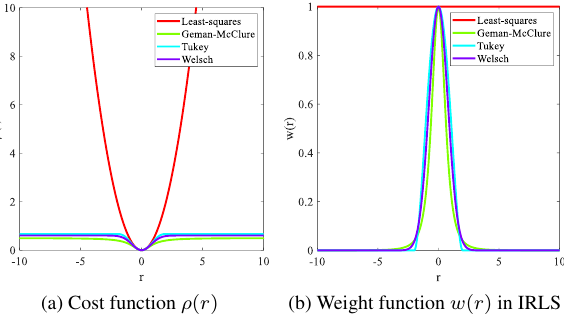
Figure 2. Visualization of the proposed cost function (a) and its weight function (b) with different “robustness-control” paramet- ers α . ( β = 1